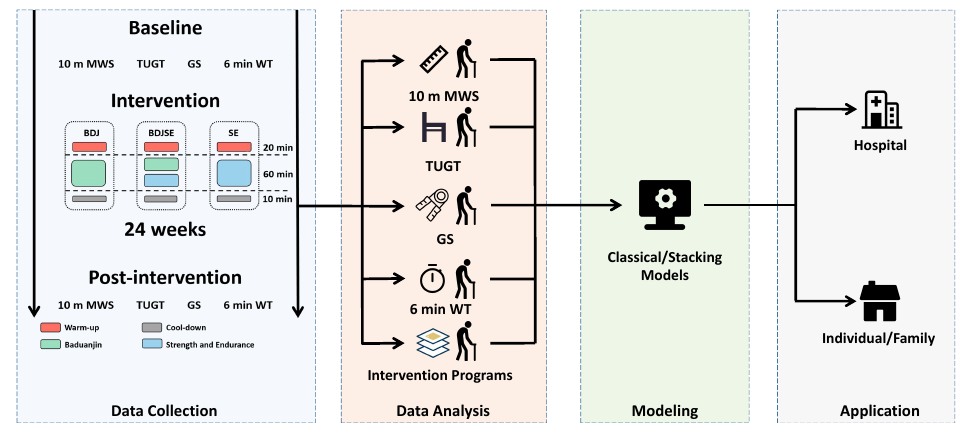
Figure 1. System design; all of the subjects were randomly assigned to one of three intervention groups: BDJ, BDJSE, or SE. At the beginning of the study and at 24 weeks, the subjects’ 10-meter maximum walk speed (10 m MWS), timed up-and-go test (TUGT), grip strength, and 6 min walk test (6 min WT) were